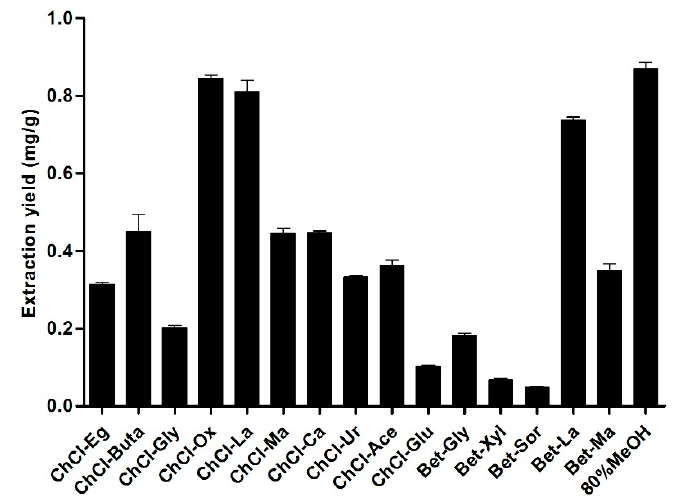
Figure 4. Rutaecarpine extraction yields of 75% ChCl and Bet-based DESs solutions, and the reference solvent 80% aqueous methanol ( v / v ) for comparison. Varied DES aqueous solution was used as a solvent to extract at a solid-liquid ratio of 1:50 with ultrasound at 35 °C and 500 W for 40 min. Data represent mean ± S.D. of triplicated experiments.